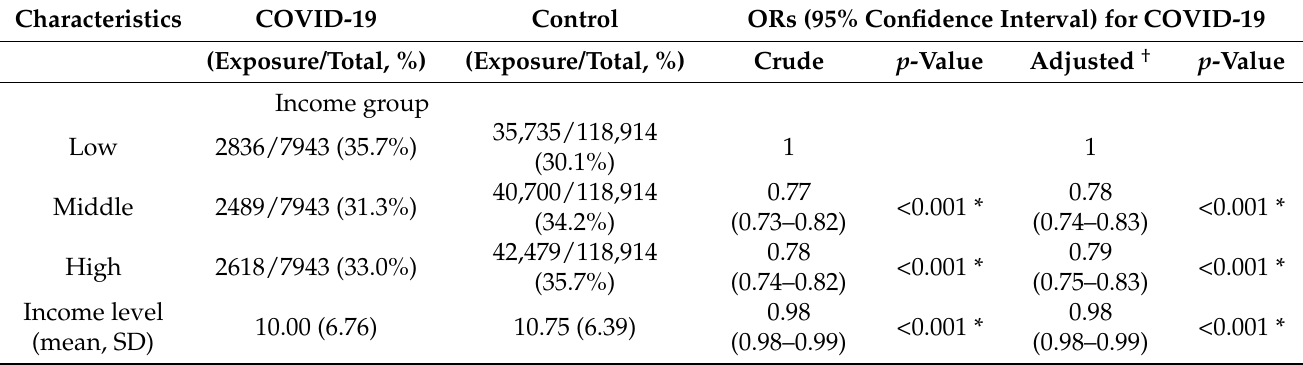
Table 2. Crude and adjusted odds ratios of the association of income with COVID-19 infection in the total participants.